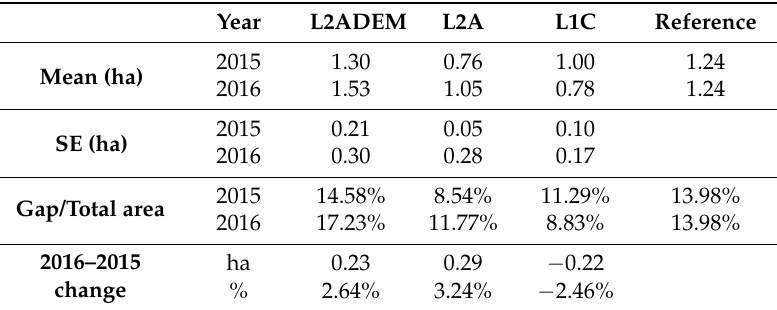
Table 7. Area evaluation results on OS2.